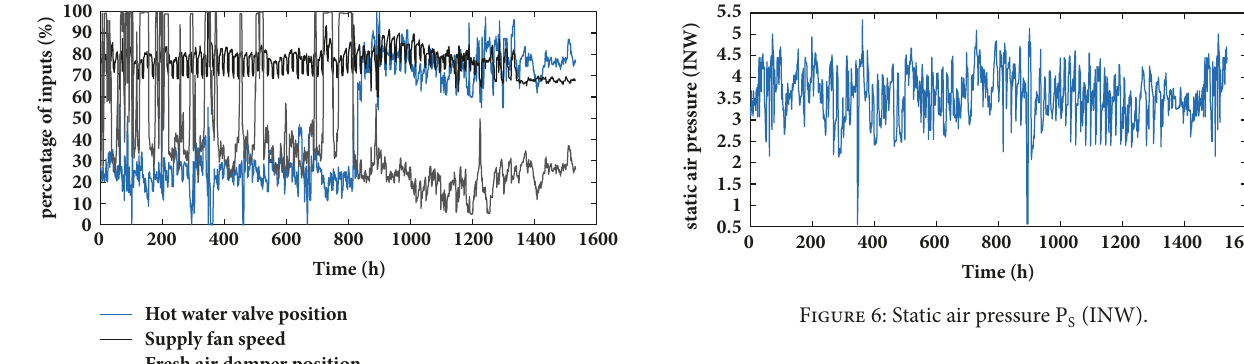
Figure 4: Inputs of AHU 1 as percentage (%).